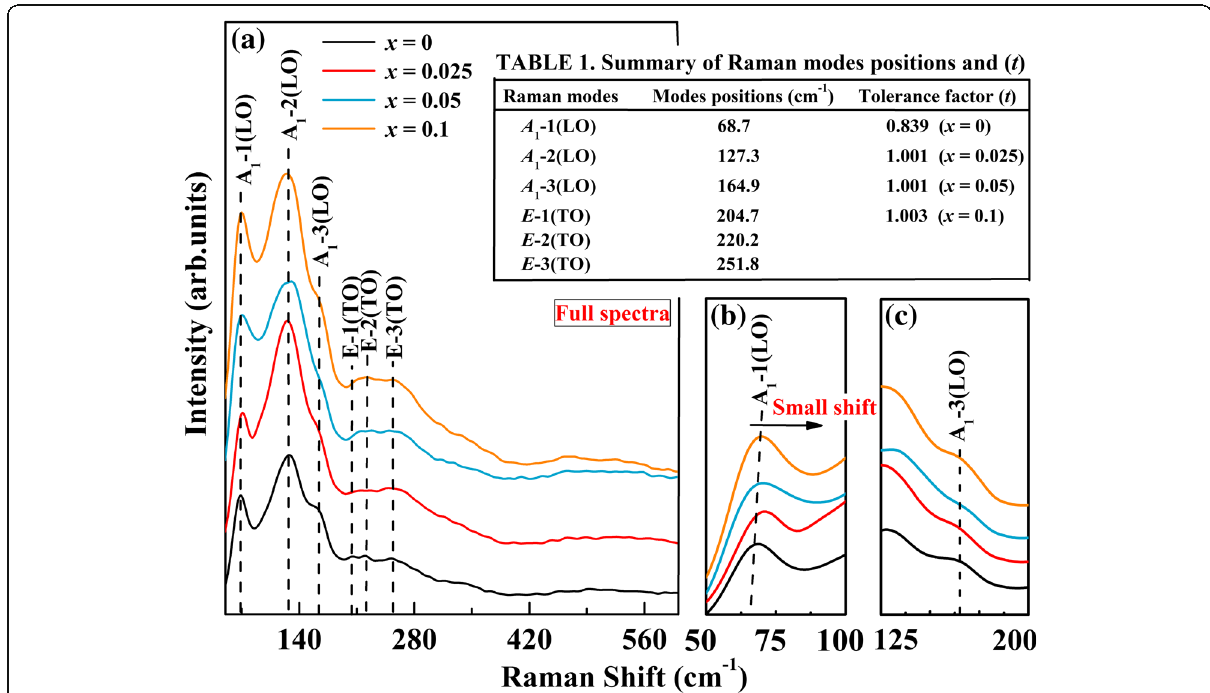
Fig. 2 a Raman spectrum of BFA x O (0 ≤ x ≤ 0.1). b Enlarged Raman spectrum in the ranges of 50 – 100 cm − 1 and c 125 – 200 cm −